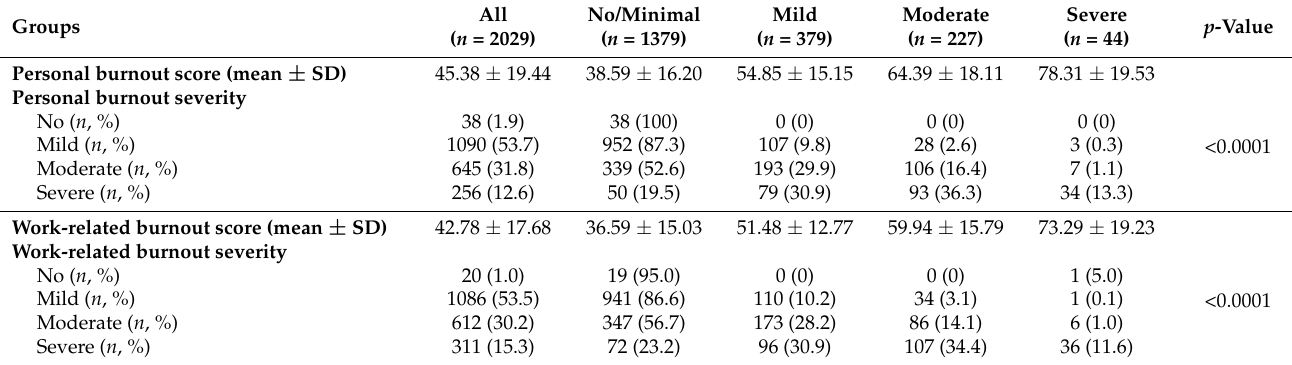
Table 2. Summary of the burnout scores of the study